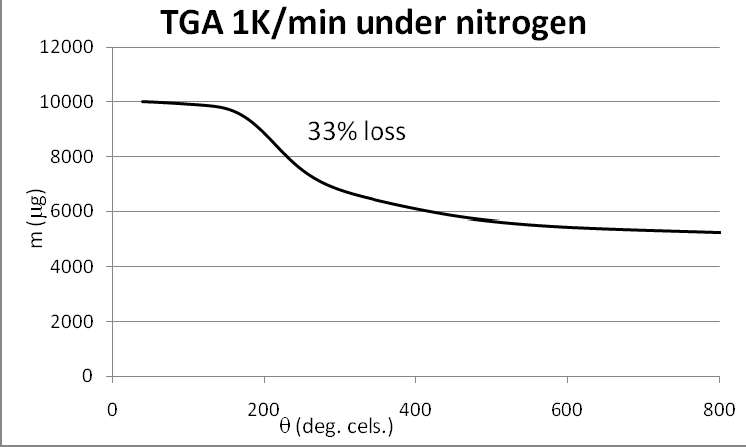
Figure 14. TGA analysis of brominated MWCNT sample CNT1 at 1 K/min under nitrogen.